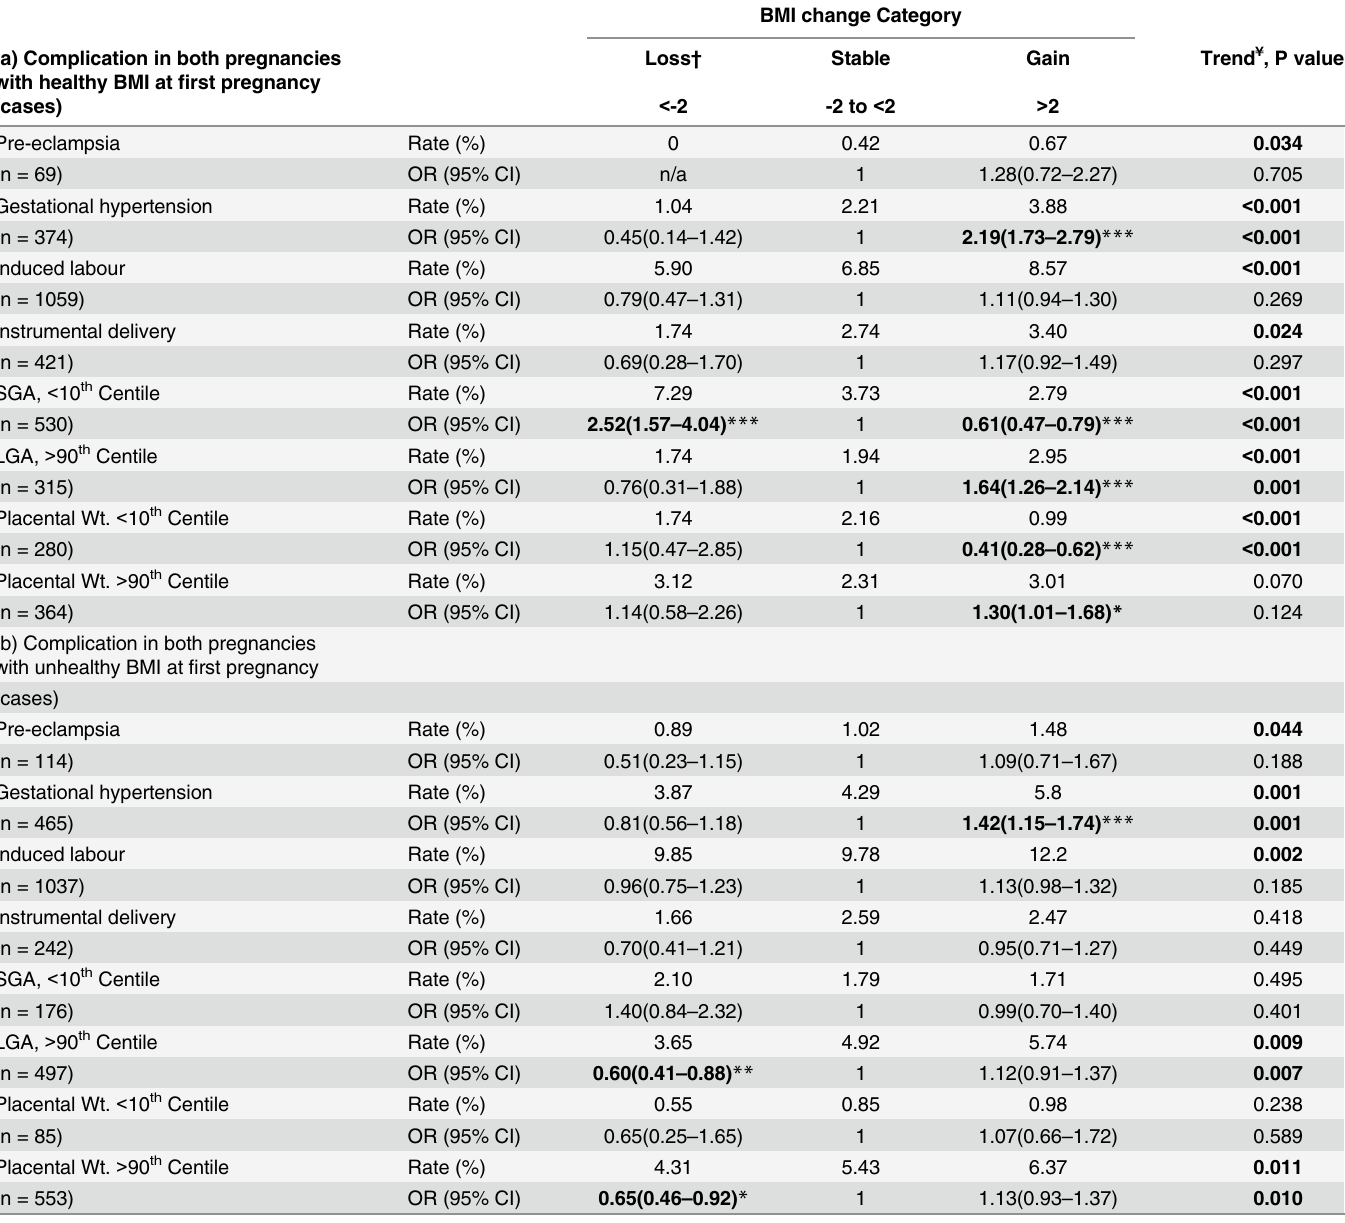
Table 5. Frequency rate and adjusted odds ratios for adverse perinatal outcomes occurring in both first and second consecutive pregnancies in relation to BMI change from first pregnancy for women with BMI (a) < 25 and (b) > 25 units in first